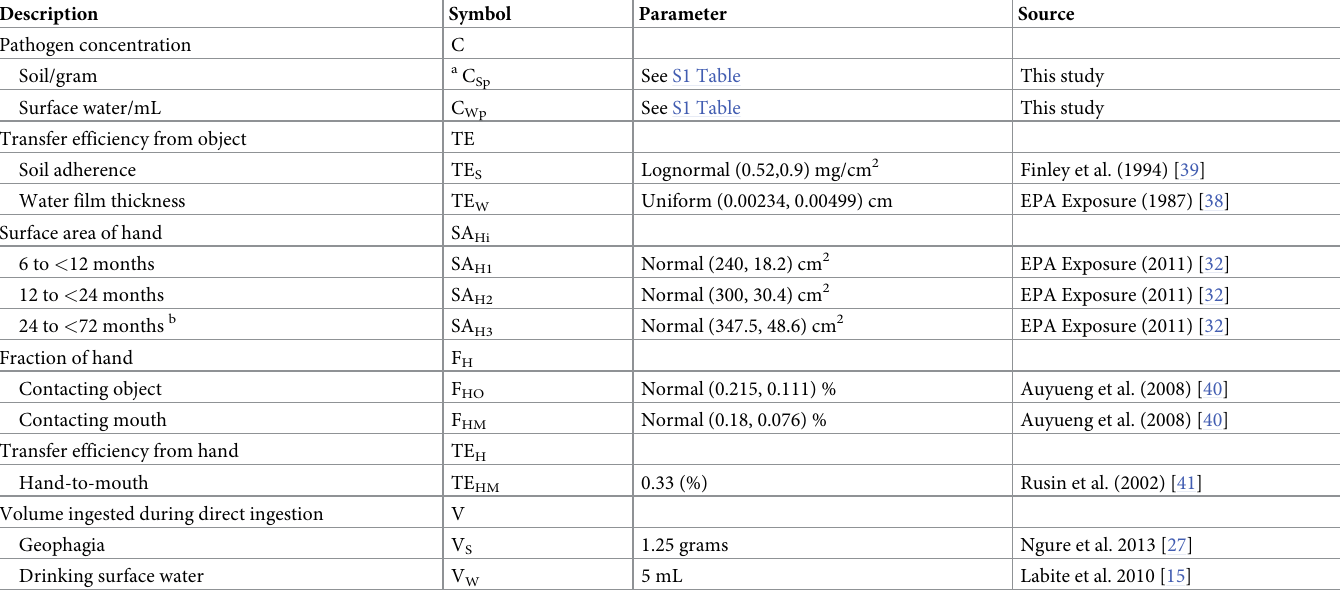
Table 1. Description of variables and parameters used to estimate distribution of indirect and direct